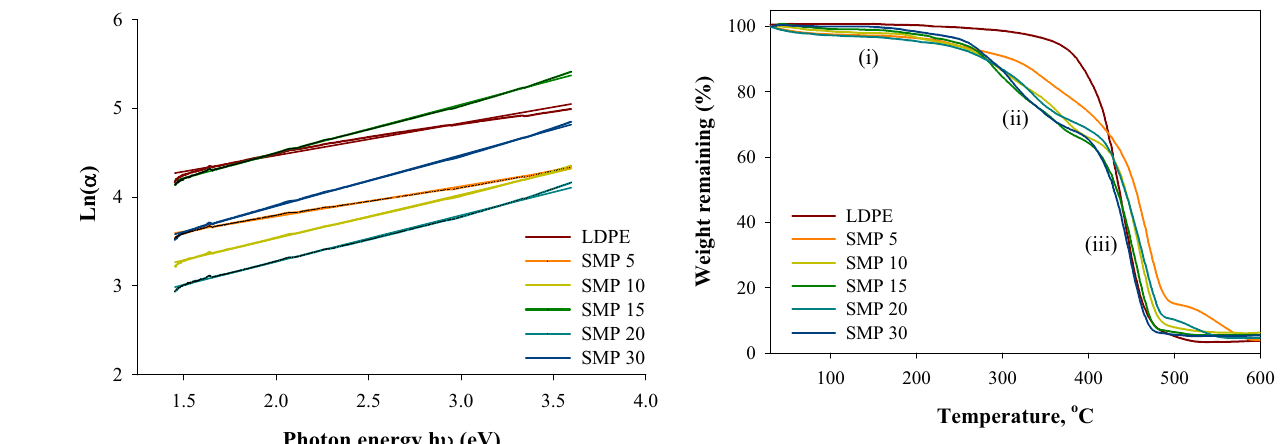
Figure 4: The logarithm of the absorption coe ffi cient, ln ( α ) , against photon energy for LDPE and grafted LDPE.